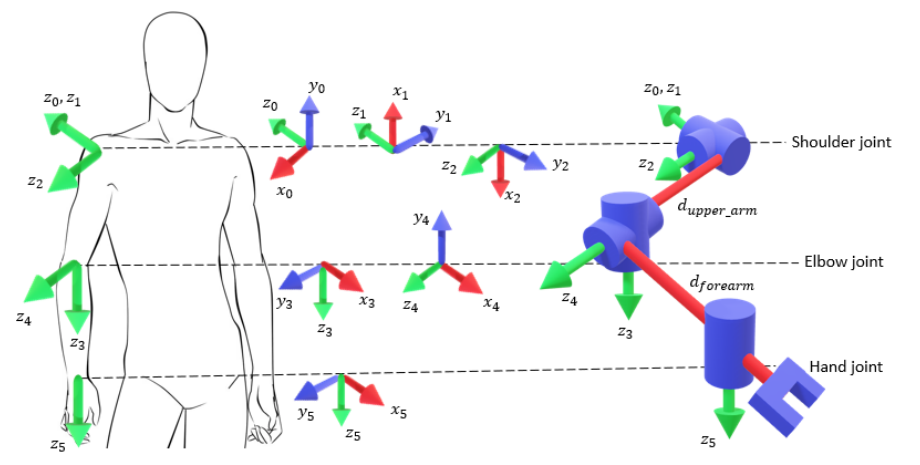
Figure 13. Link frame attachments to the human right